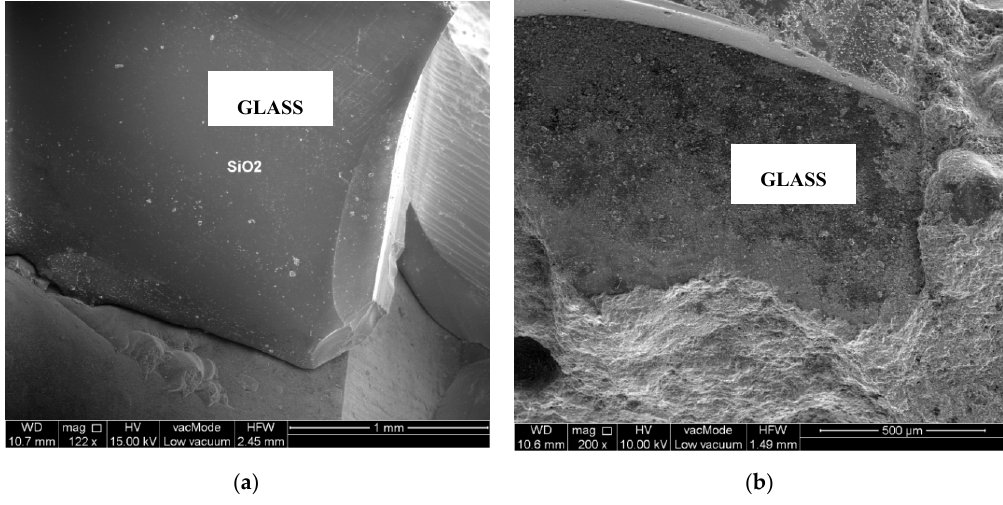
Figure 11. SEM. The microstructure of glass at temperatures of: ( a ) 20 °C; ( b ) 800 °C.